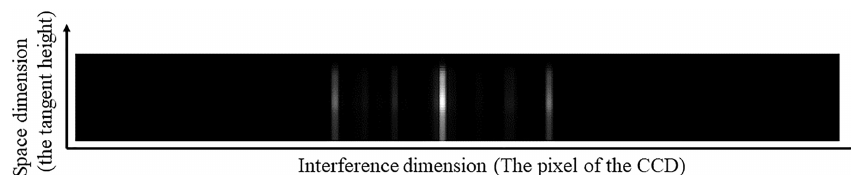
Figure 13. Graph of OH fluorescence emission